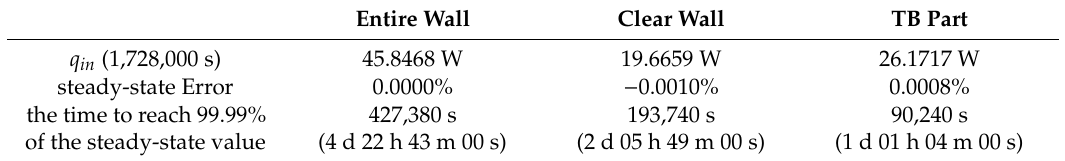
Figure 6. Dynamic simulation results for system identification of the TB part. T o is the outdoor temperature and q in is the heat flow into the room.